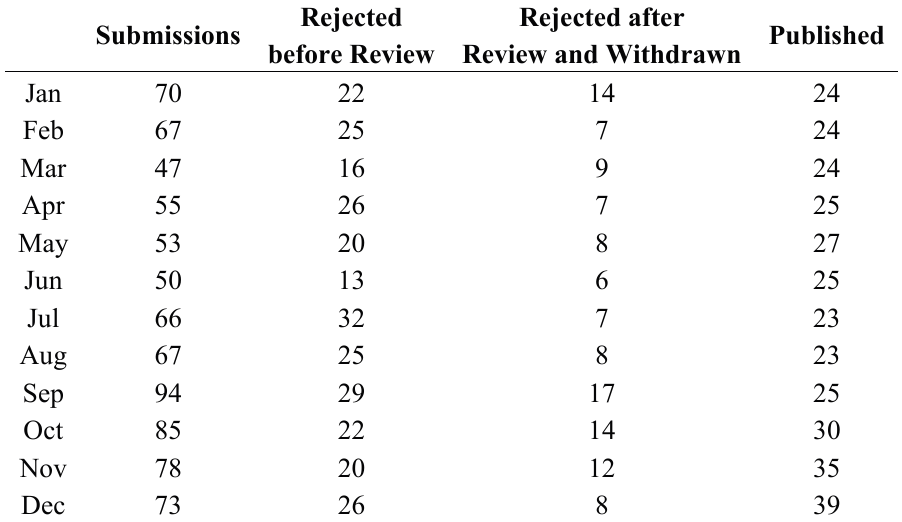
Table 1. List of submission and rejection statistics per month in 2013, in issue months. Rejected Rejected after Submissions before Review Review and Withdrawn